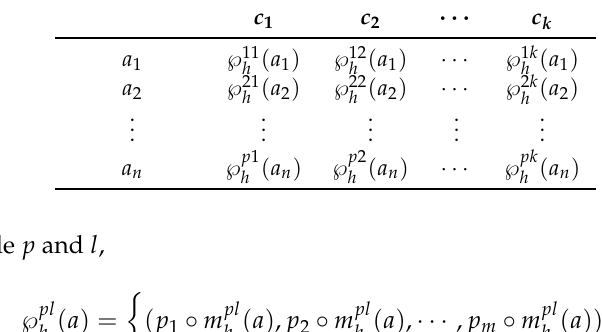
Table 8. Tabular representation of H m F decision matrix. Hesitant m -Polar Fuzzy Criteria Alternatives c 1 c